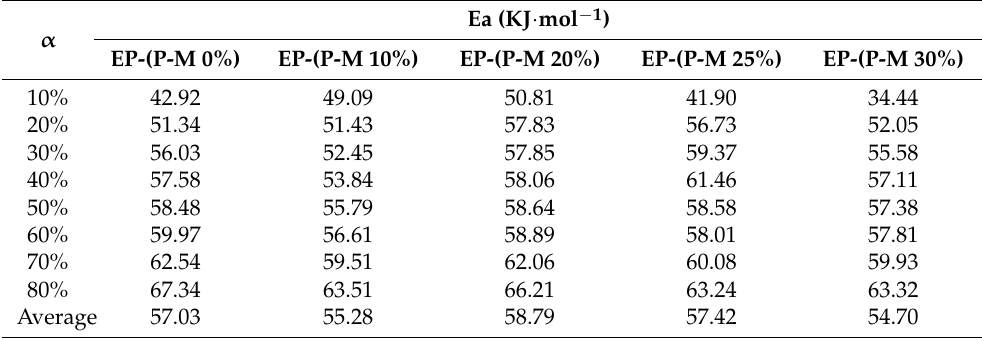
Table 2. F–W–O method to calculate the thermal degradation kinetic